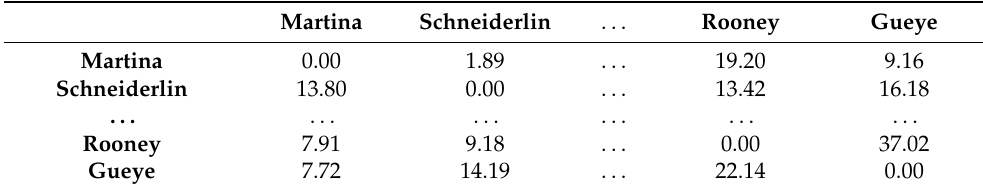
Table 1. Premier League round 1 Everton pass weight adjacency